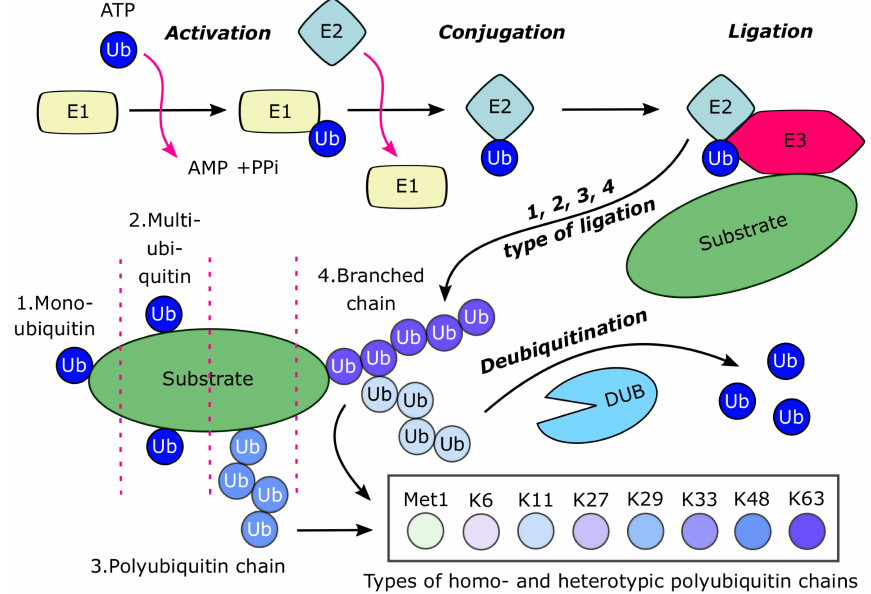
Figure 2. Overview of the ubiquitinating system (Abbreviations: Ub—ubiquitin, E1—ubiquitin activating enzyme, E2—ubiquitin conjugating enzyme, E3—ubiquitin ligase, DUB—deubiquitinase enzyme, Met—methionine,